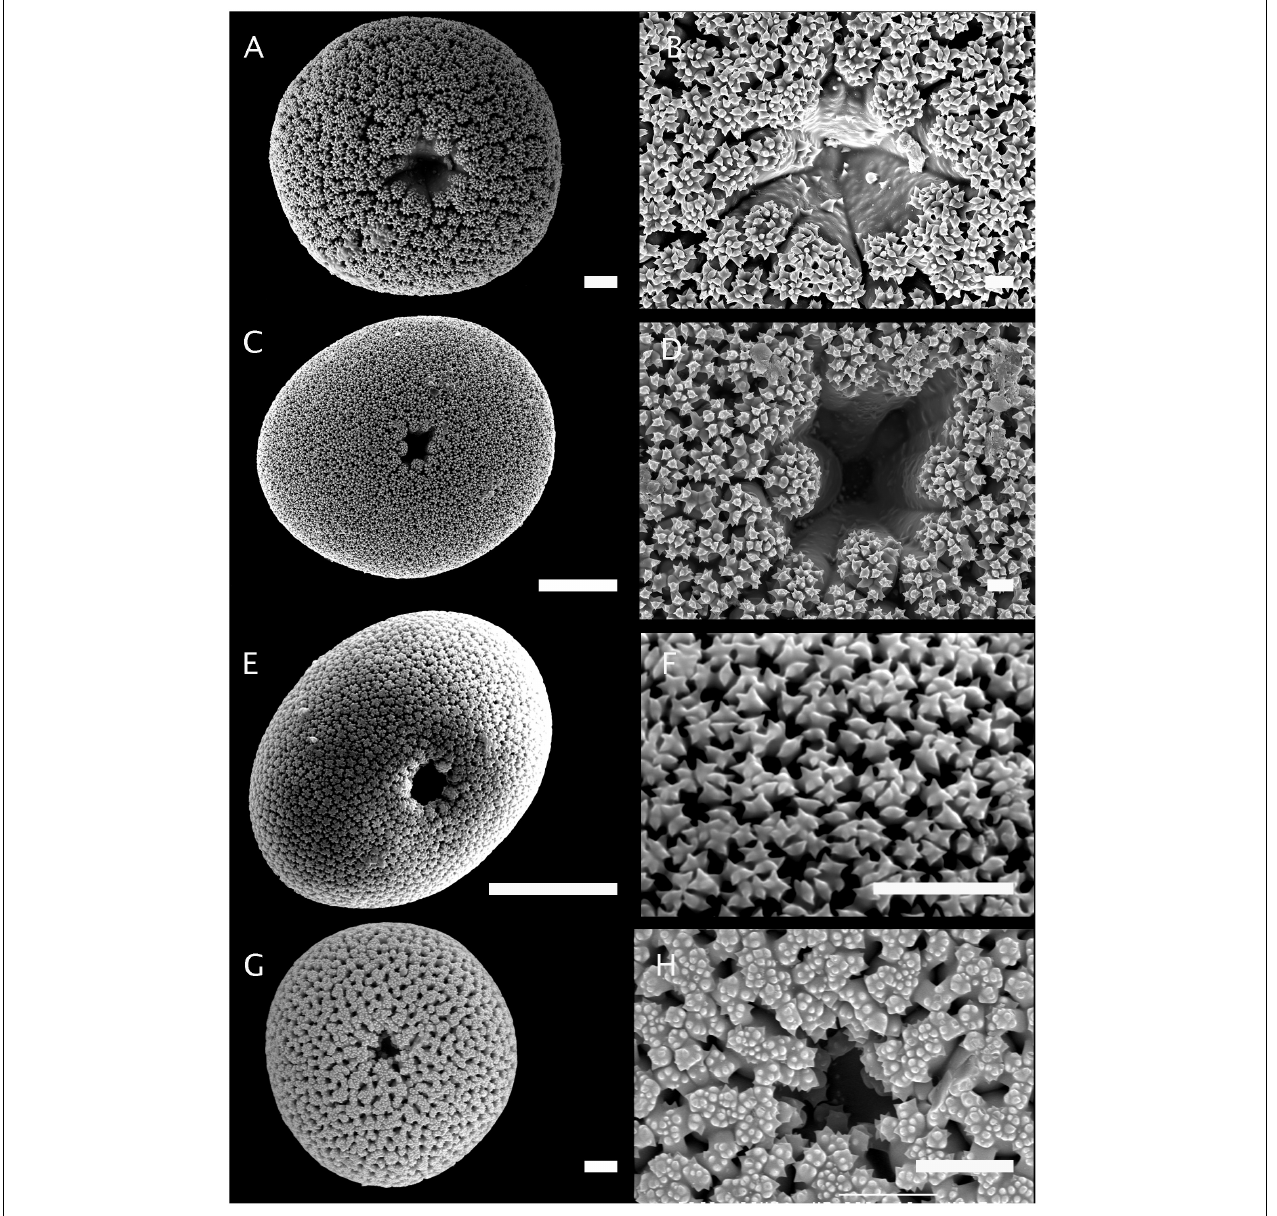
FIGURE 4 | Morphology of sterrasters from Pachymatisma , Caminus, and Caminella . (A,B) Sterraster of Pachymatisma johnstonia (Roscoff, France, MNHN-DCL 4015). Scale A: 10 µ m. Scale B. 3 µ m. (C,D) Sterraster of Pachymatisma normani (Norway, ZMBN 77858). Scale C: 40 µ m. Scale D. 2 µ m. (E) Sterraster of Caminus chinensis (holotype, UPSZTY 2102). Scale E: 50 µ m. (F) Sterraster of Caminus sp. (Îles Glorieuses, MNHN-IP-2015-1144). Scale F: 10 µ m. (G,H) Sterraster of Caminella pustula (holotype, MNHN-IP-2008-4). Scale G: 10 µ m. Scale H: 10 µ